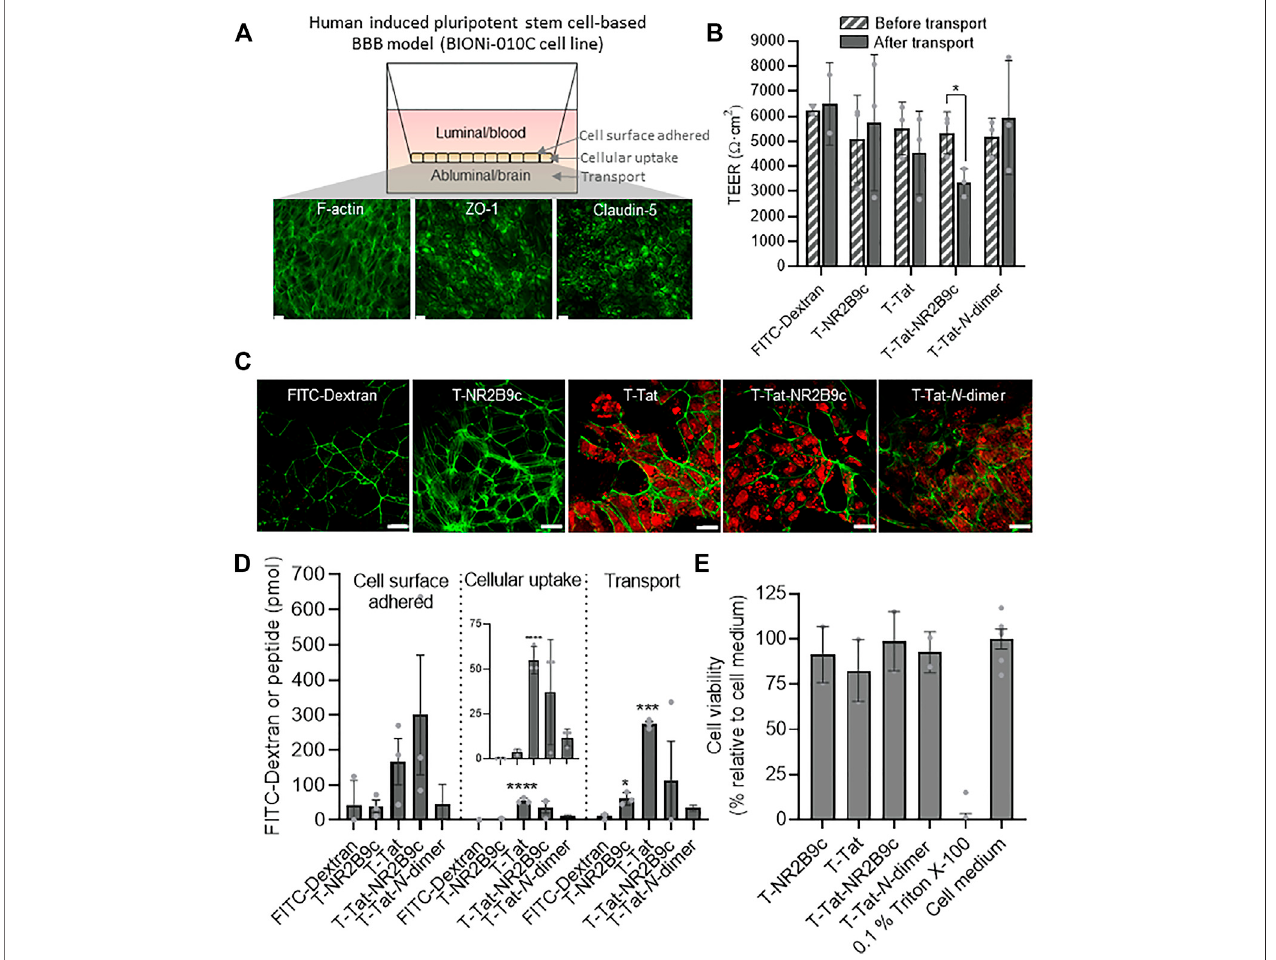
FIGURE 3 | Peptide transport across and uptake into monolayers of the human pluripotent stem cell line BIONi010-C after 4-h incubation with 50 μ M T-NR2B9c, T-Tat, T-Tat-NR2B9c, or T-Tat- N -dimer at 37 ° C. FITC-Dextran (3 – 5 kDa) was included as a reference paracellular marker. (A) Illustration of BIONi010-C cells differentiated into monolayers of brain capillary endothelial-like cells with representative F-actin phalloidin staining or zonula occludens-1 (ZO-1) and claudin-5 immunostainings imaged by fl uorescence microscopy. Scale bar: 50 µm. (B) Transendothelial electrical resistance (TEER) measurements across BIONi010- C – derived cell monolayers before and after transport experiment. Mean ± SD ( N = 3, n = 3); *: p < 0.05 (unpaired t -test) (C) Confocal laser scanning images of fi xated BIONi010-C monolayers after a transport study. Dextran or peptide uptake was visualized via FITC or TAMRA fl uorescence (red), respectively, whereas the cell morphology was outlined via F-actin staining using phalloidin (green). (D) Dextran and peptide cell surface adherence to, cellular uptake into, and transport across BIONi010-C monolayers. Mean ± SD ( N = 3, n = 3); *: p < 0.05, ***: p < 0.001, and ****: p < 0.0001 compared to FITC-Dextran (one-way ANOVA with Tukey ’ s multiple comparisonstest). (E) BIONi010-Ccellviabilitydepictedaspercentagerelativebuffercontrol.TritonX-100wasincludedascontrolfor100%deadcells.Mean±SD( N = 3, n =